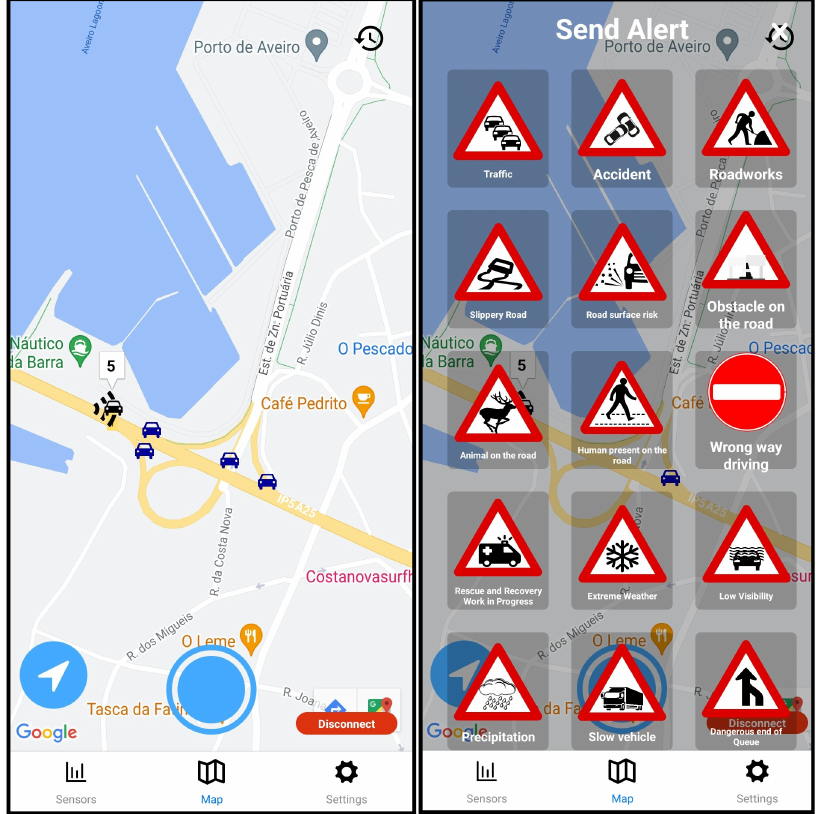
Figure 4. CCAM application: visualization of an RSU transmitting CPMs ( left ); and the alert (DENM) generation panel for the user to disseminate warnings ( right